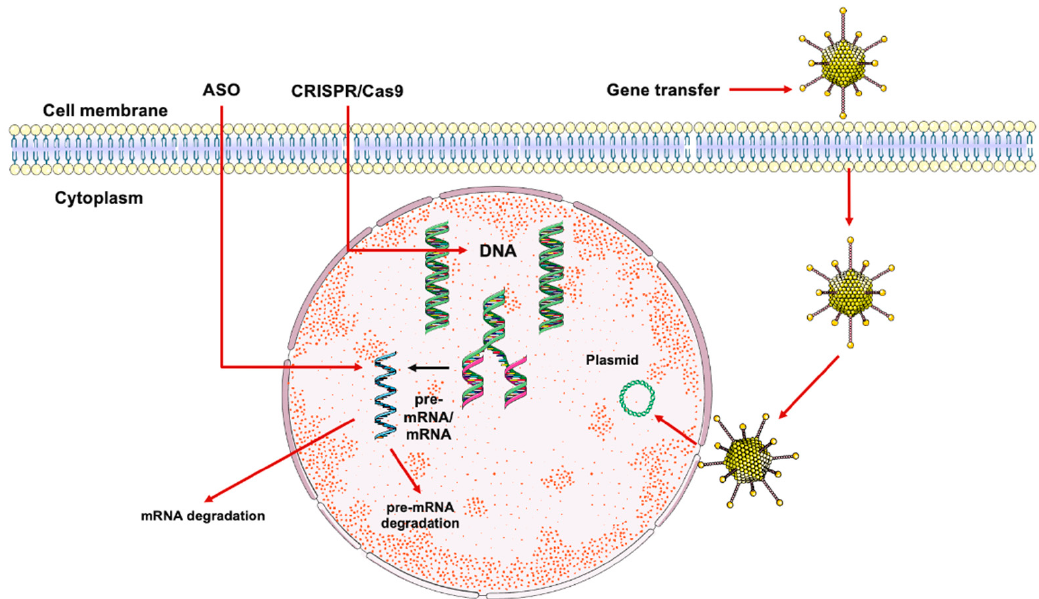
Figure 1. Endogenous pathways may be exploited to achieve therapeutic gene manipulation. Antisense oligonucleotides (ASOs) complementary to nuclear pre-mRNAs or cytoplasmic mRNAs exploit the RNAse-mediated pathway, binding to complementary sequences to induce their degradation. This process may occur both in the nucleus and in the cytoplasm. Clustered regularly interspaced short palindromic repeats (CRISPR)/CRISPR-associated protein 9 (Cas9) acts on double- stranded DNA, causing breakage at target sites in the genome. Gene transfer is achieved via viral vectors, usually an adeno-associated virus or a lentivirus, that are used to carry complementary DNA sequences into the cells, to induce the expression of one or more particular genes. Figure modified from images from Servier Medical Art, licensed under a Creative Common Attribution 3.0 Generic License. http://smart.servier.com/, accessed on 25 July